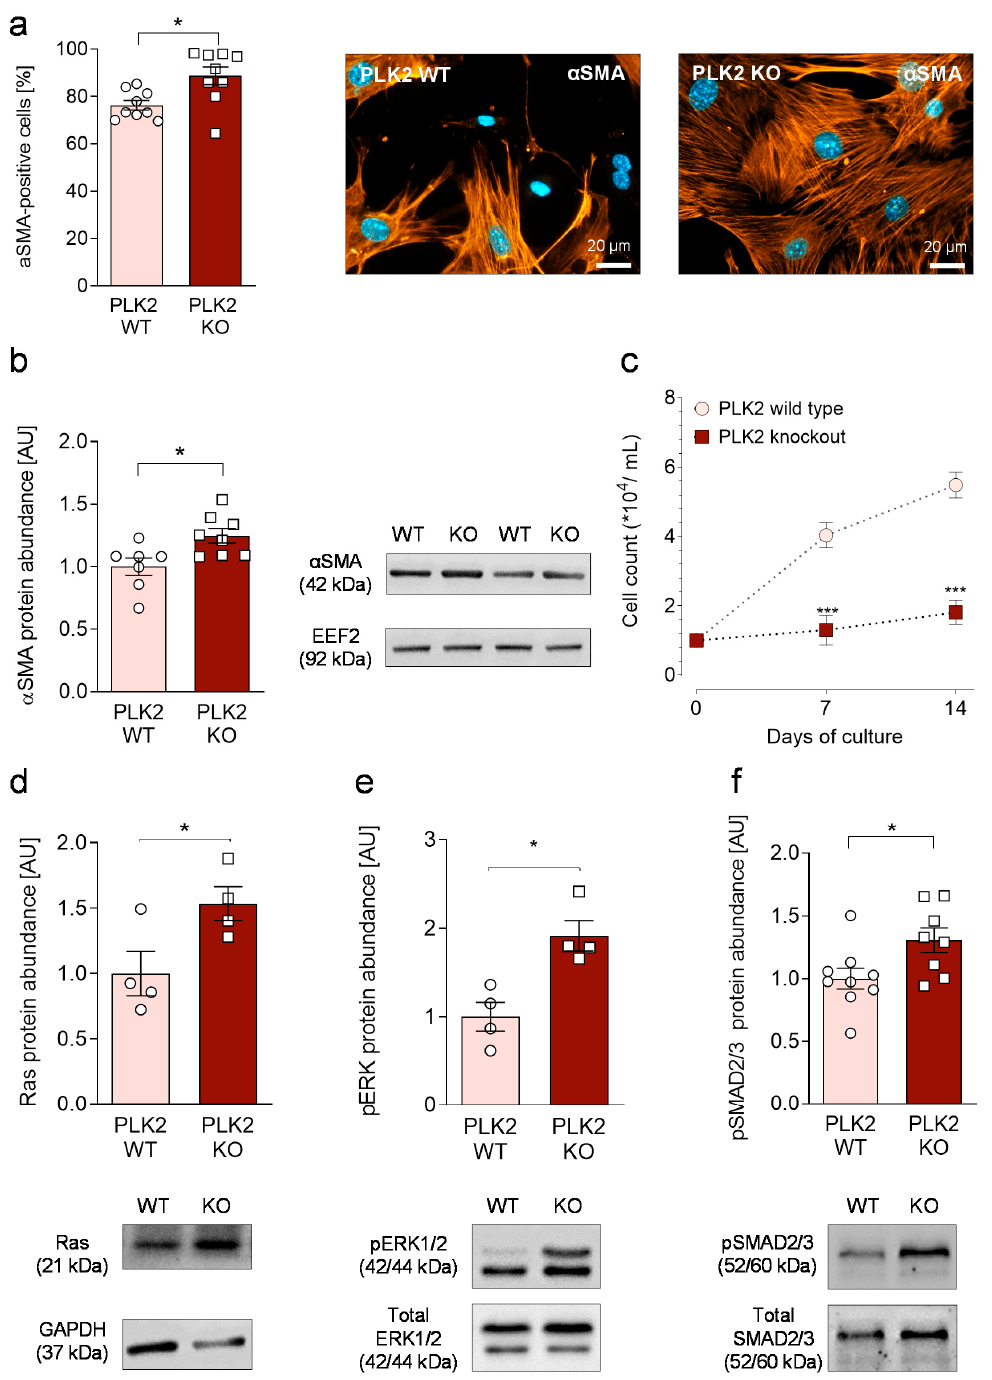
Figure 1. Characterization of the pulmonary fibroblast phenotype in PLK2 WT and KO. ( a ) Quantification and representative immunofluorescence images of α SMA myofilaments in primary PLK2 WT and KO fibroblasts ( n WT = 9, n KO = 9). The nuclei were stained with DAPI (blue). The scale bars equal 20 µm. ( b ) Quantification and representative Western blot for α SMA in primary PLK2 WT and KO fibroblasts ( n WT = 7, n KO = 8). ( c ) Proliferation curves of primary pulmonary PLK2 WT and KO fibroblasts under control conditions ( n WT = 14 from 7 animals, n KO = 10 from 5 animals). Cells were counted after 7 and 14 days. ( d ) Quantification and representative Western blot for Ras ( n WT = 4, n KO = 4). ( e ) Quantification and representative Western blot for ERK1/2 phosphorylation ( n WT = 4, n KO = 4). ( f ) Quantification and representative Western blot for SMAD2/3 phosphorylation ( n WT = 9, n KO = 8). * p < 0.05. *** p < 0.001.